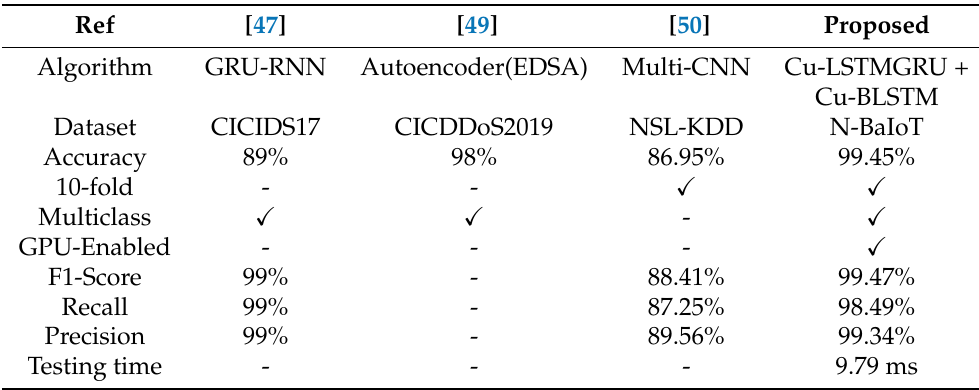
Table 6. Comparison with existing